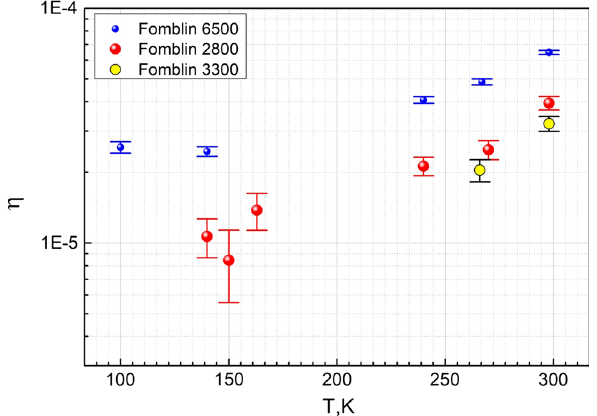
Fig. 4 Temperature dependence of the loss coefficient for Fomblin Y